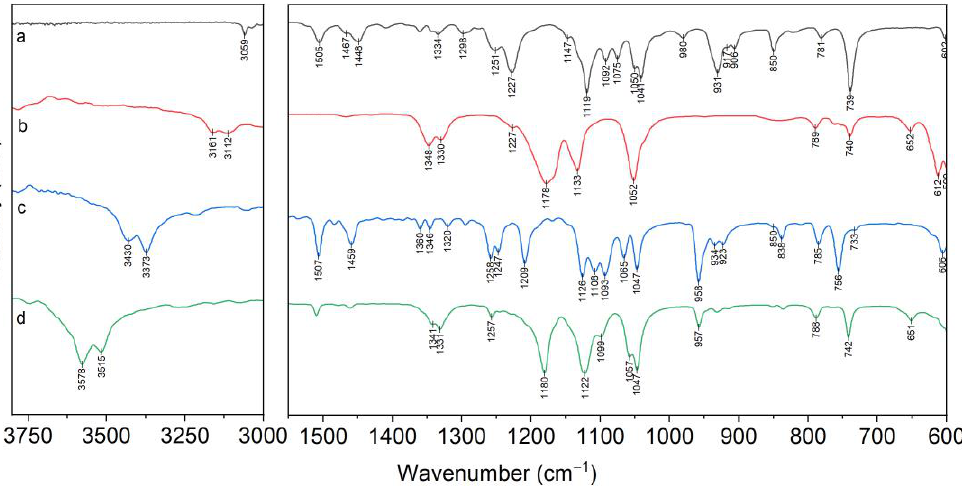
Figure 11. FTIR spectra: a — B15C5; b — [C8mim][NTf 2 ]; c — [Li(B15C5)(H 2 O)Cl]; d — [Li(B15C5)(H 2 O)(NTf 2 )] (I) . The 1000–800 cm − 1 range is the most significant for spectra analysis of B15C5 and its com- plexes as it is characterized by the presence of the combined stretching–deformation modes ρ (CH2) + ν (CO) + ν (CC) of the ethylene glycol fragments of the crown ether [33]. Furthermore, in this range of free B15C5 spectrum, the band ν s (COC) 981 cm − 1 is located, which we used earlier as the most characteristic bands for describing the complexation [22,32,34]. This band shifts to the low-frequency region by 20–30 cm − 1 in the spectra of lithium complexes with B15C5 with various anions (Cl − , I − , ClO 4 − , NO 3 − , BF 4 − , NCS − ). The isolated position of this band makes it suitable for controlling the complexation process. The ν s (COC) band shift up to 957 cm − 1 is also observed in spectrum of complex ( I ) (Figure 11). The spectrum of complex ( I